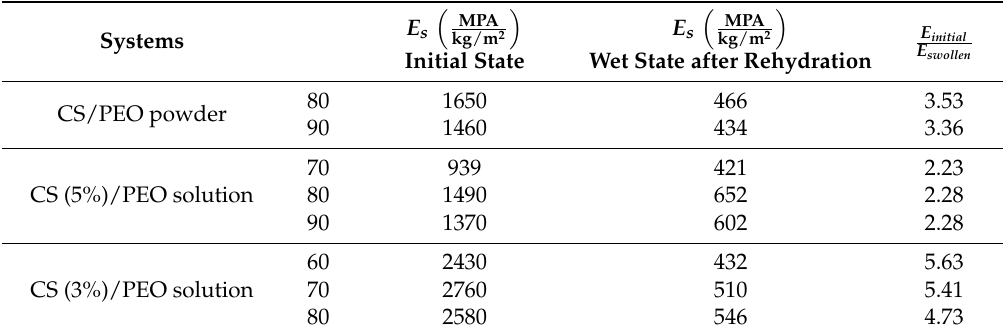
Table 6. Experimental values of E s obtained in DMA on initial blended fibers and after PEO extraction ( MW = 5 × 10 6 ) used in powder form and in 5% and 3% solutions under swollen state after drying and rehydration.